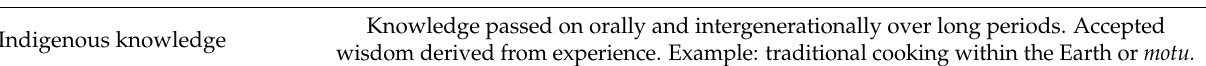
Table 4. Knowledge types defined from community studies in Ghizo. This work has identified the role of a wide range of knowledge types in community responses to the 2007 tsunami. Whilst indigenous knowledge is important, it is by no means the only knowledge type that is of significance. What is missing is the inter-communal sharing of knowledge. Knowledge Type Knowledge Source Indigenous